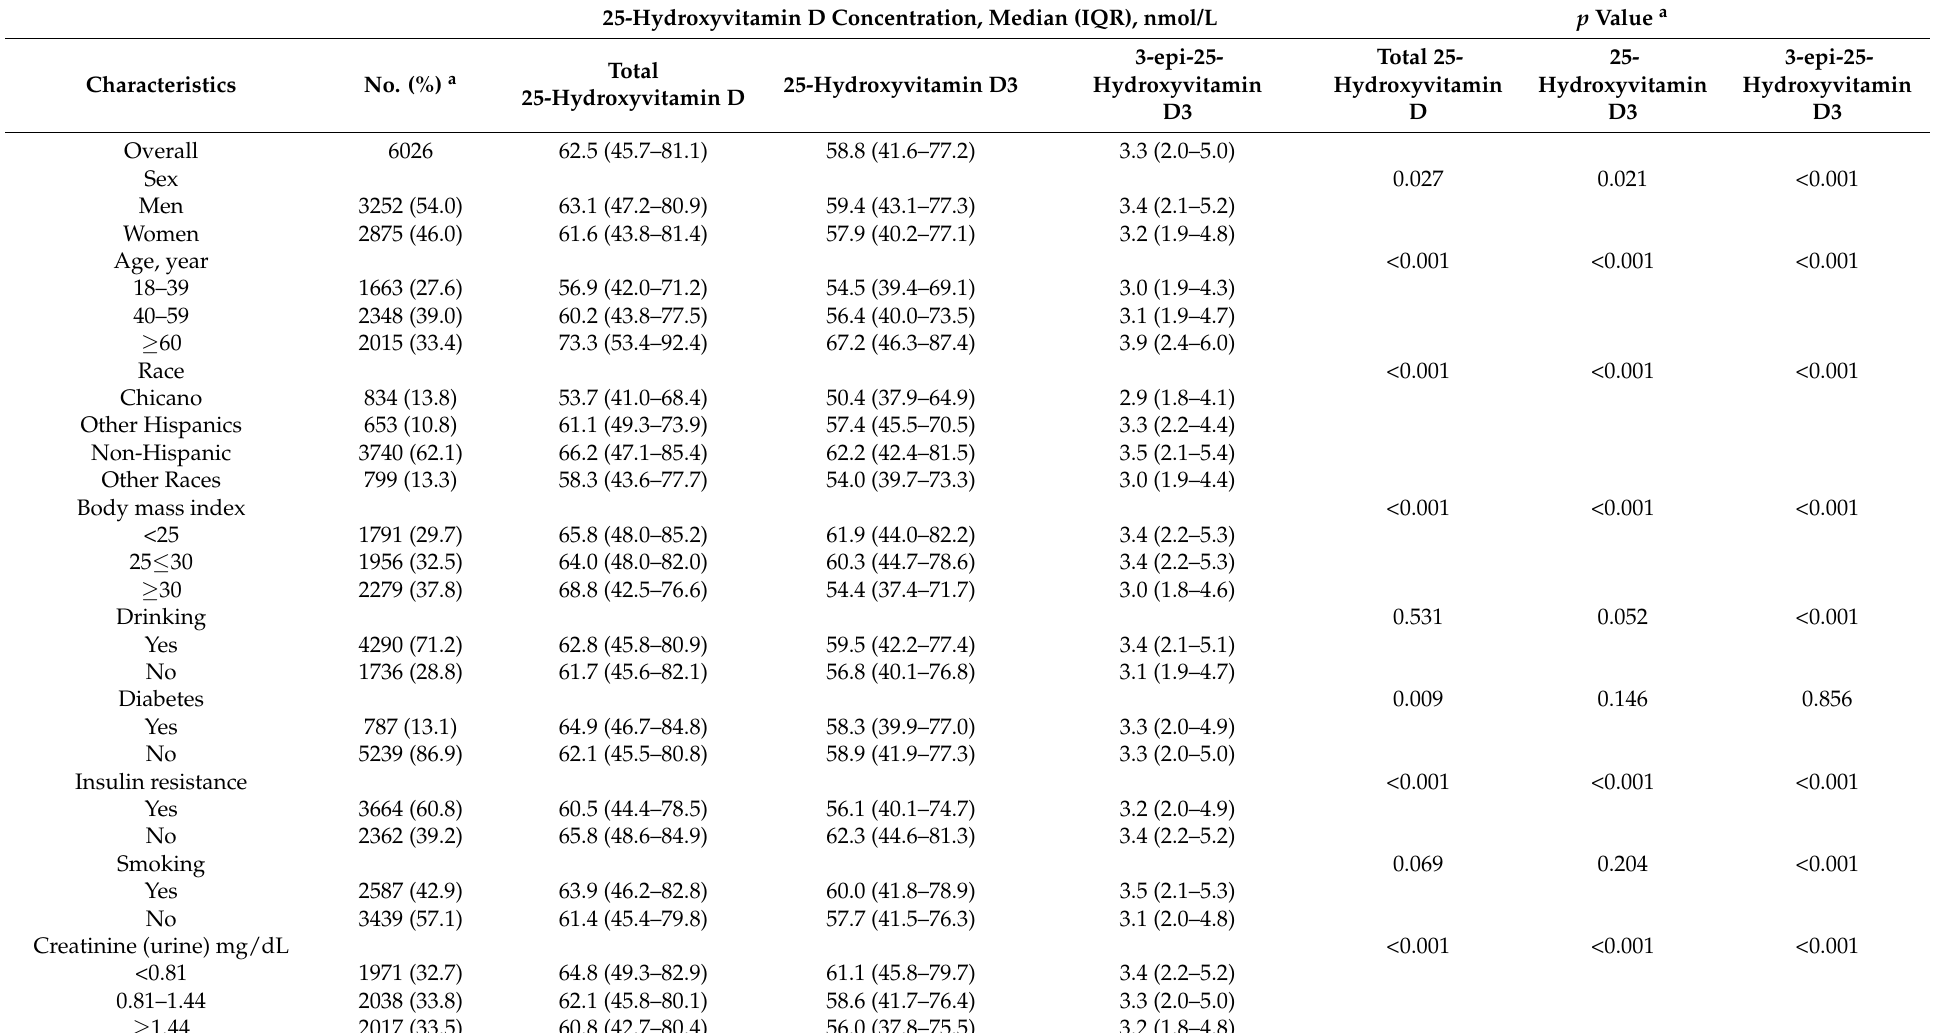
Table 1. Concentrations of 25-hydroxyvitamin D according to Participant